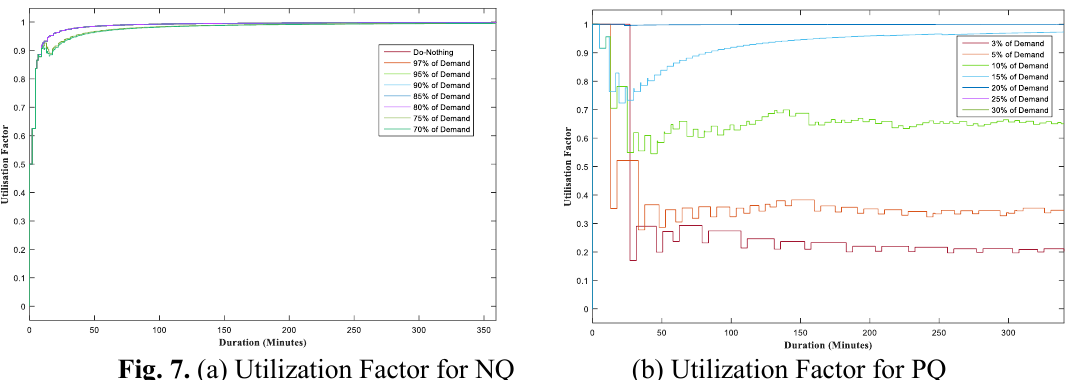
Fig. 7. (a) Utilization Factor for NQ (b) Utilization Factor for